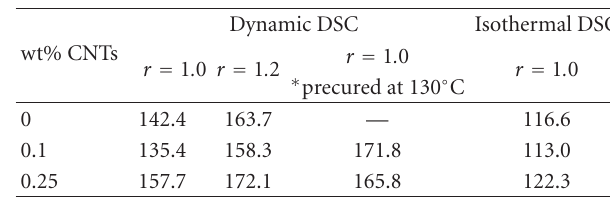
Table 4: T g ( ◦ C) values of neat and nanoreinforced epoxy resins after DSC